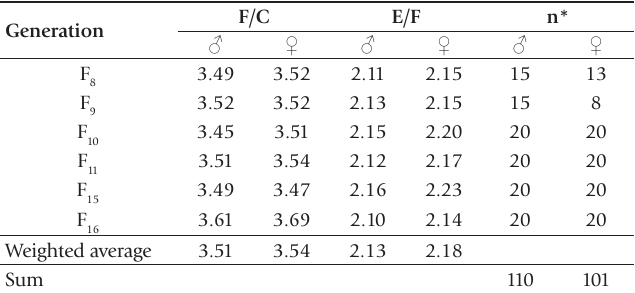
Table 1. Morphometrics of crowded Schistocerca gregaria , normal strain.